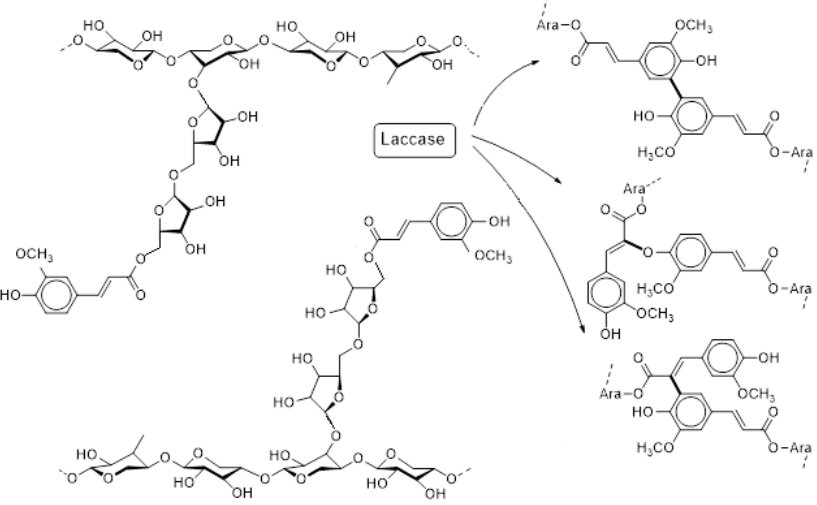
Figure 1. Oxidative gelation as catalyzed by laccases (simplified): Feruloylated arabinoxylan in solution ( left ) and formation of network knots to constitute a gel ( right ); β -1,4- d -Xylopyranose backbone with α -1,3- l -arabinofuranosyl side chains carrying feruloyl substituents. Dimerization of adjacent feruloyl moieties occurs through intermediate carbon or oxygen centered radicals.